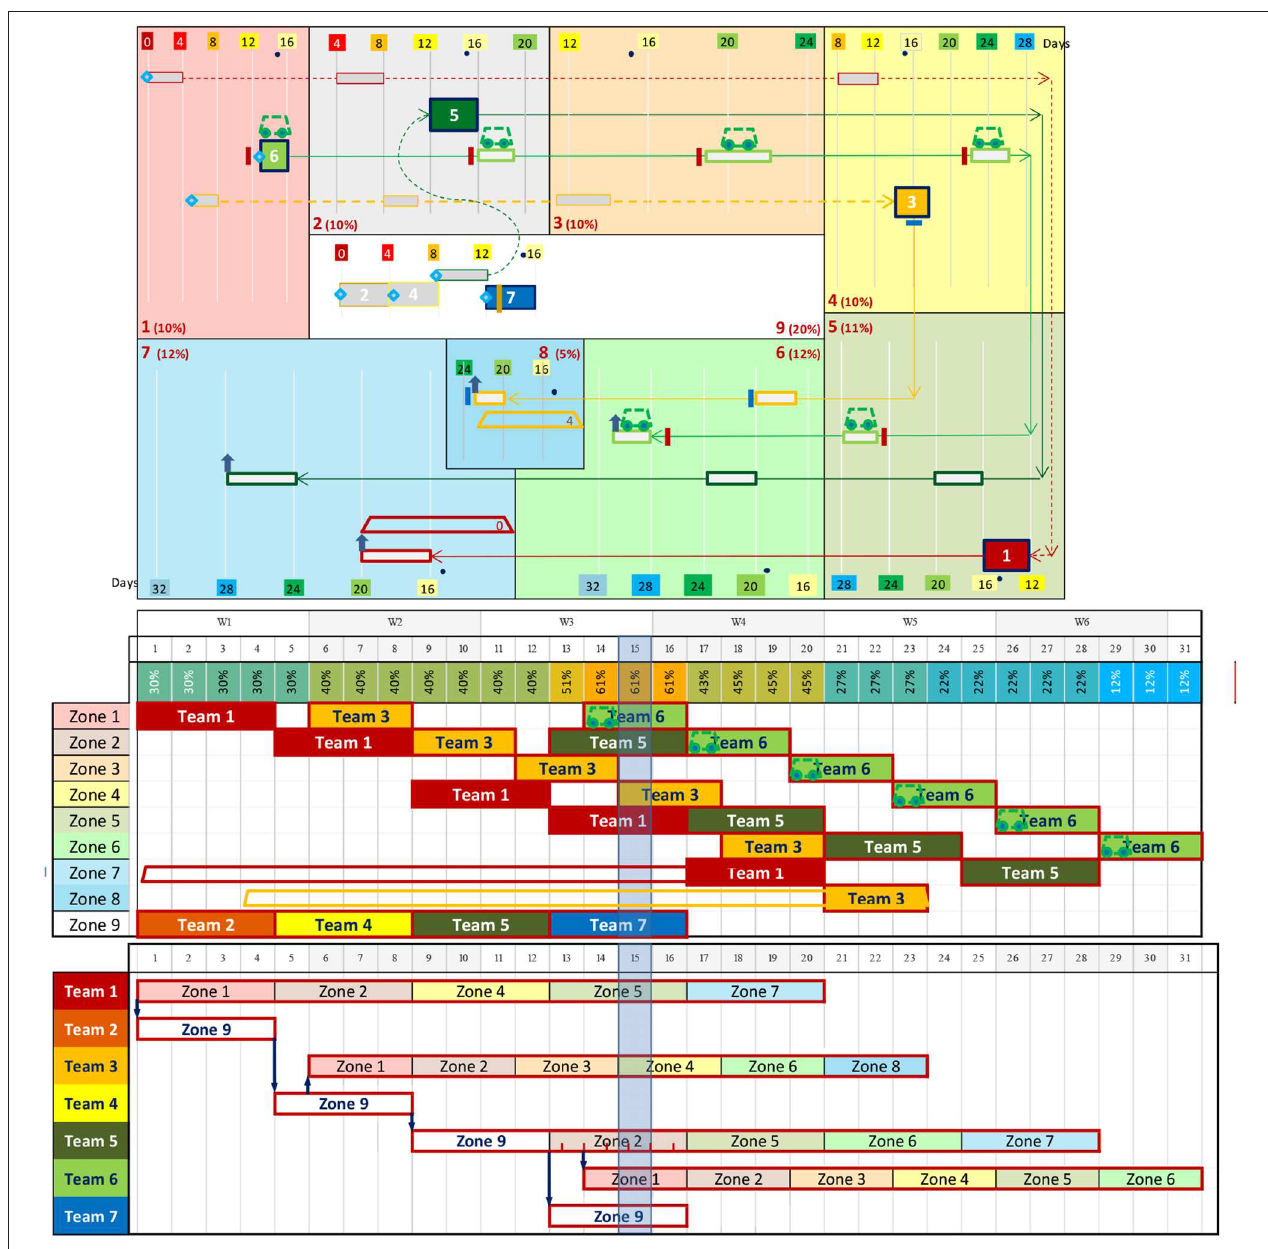
FIGURE 3 | Applied example for the site-spatial-temporal